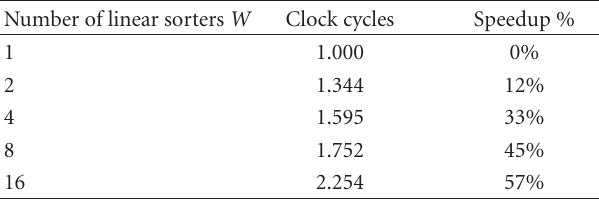
Table 4: Reduced average latency for interleaved linear sorter of width W .